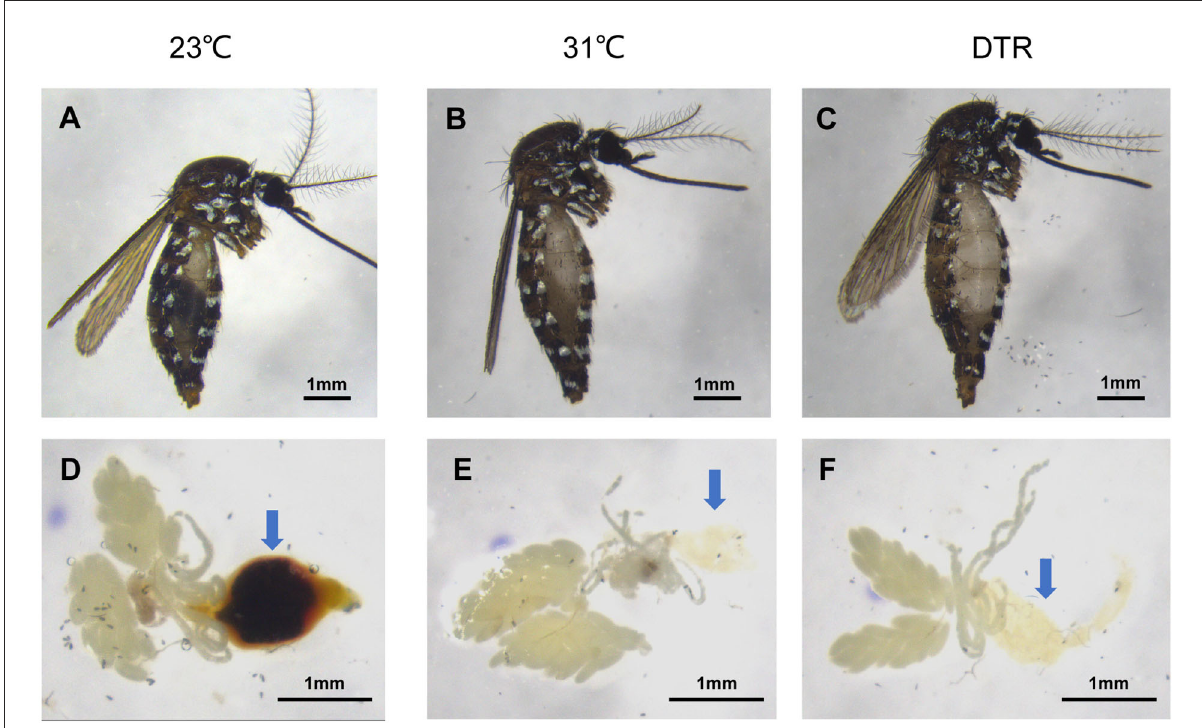
FIGURE5 Digestion degree of blood bolus in Ae. albopictus infected with Zika virus at different temperatures 3dpi. Lateral view of the mosquito body (A–C) . Anatomical view of internal organs (D–F) . Arrow points to the midgut tissue.